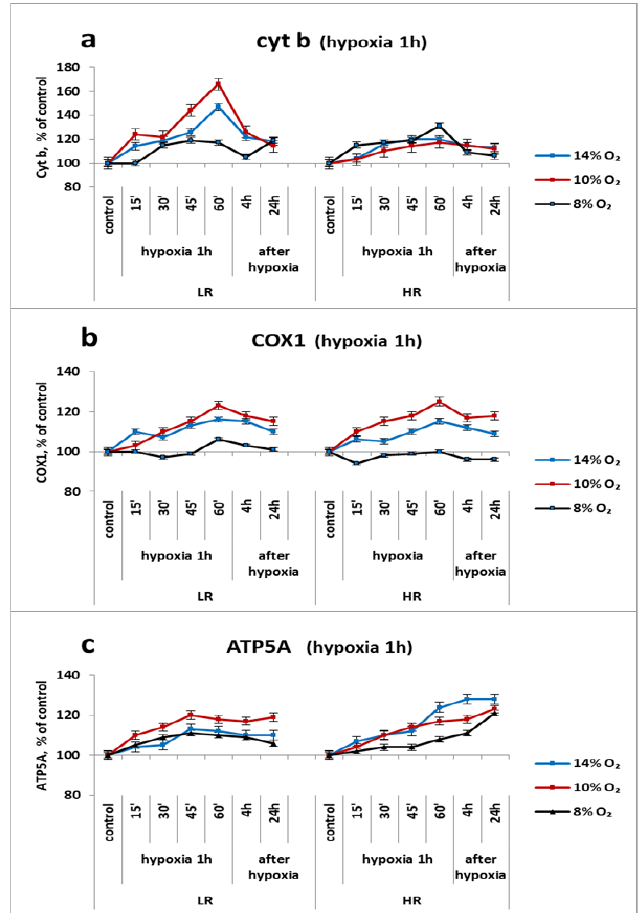
Figure 4. Dynamics of the expression of catalytic subunits of respiratory enzymes (Cyt b ( a ), COX2 ( b ) and ATP5A ( c ) in LR and HR rat myocardium during a single 1-h hypoxic exposure (HBH, FiO 2 – 14, 10, 8% О 2 ) and in the post-hypoxic period (see Figure